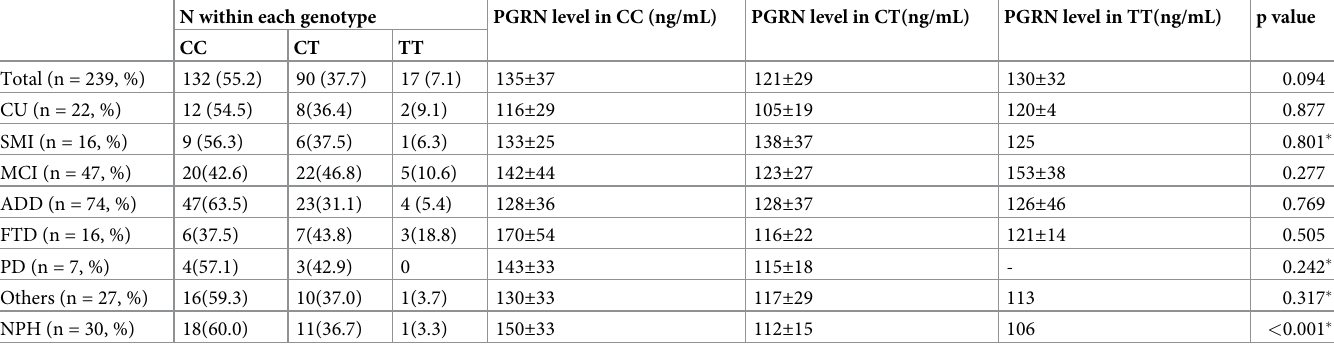
for the CU participants and 55.3% for the patients), followed by the CT genotype (36.4% for the CU participants and 37.8% for the patients), and the least frequent genotype was the TT genotype (9.1% for the CU participants and 6.9% for the patients). In the CU, SMI, ADD, PD, NPH, and other neurodegenerative disease groups, the CC genotype was the most common, whereas in the MCI and FTD groups, the CT genotype, fol- lowed by the CC and TT genotypes, was the most frequent. The TT genotype was the least fre- quent in all diagnostic groups (Table 3).